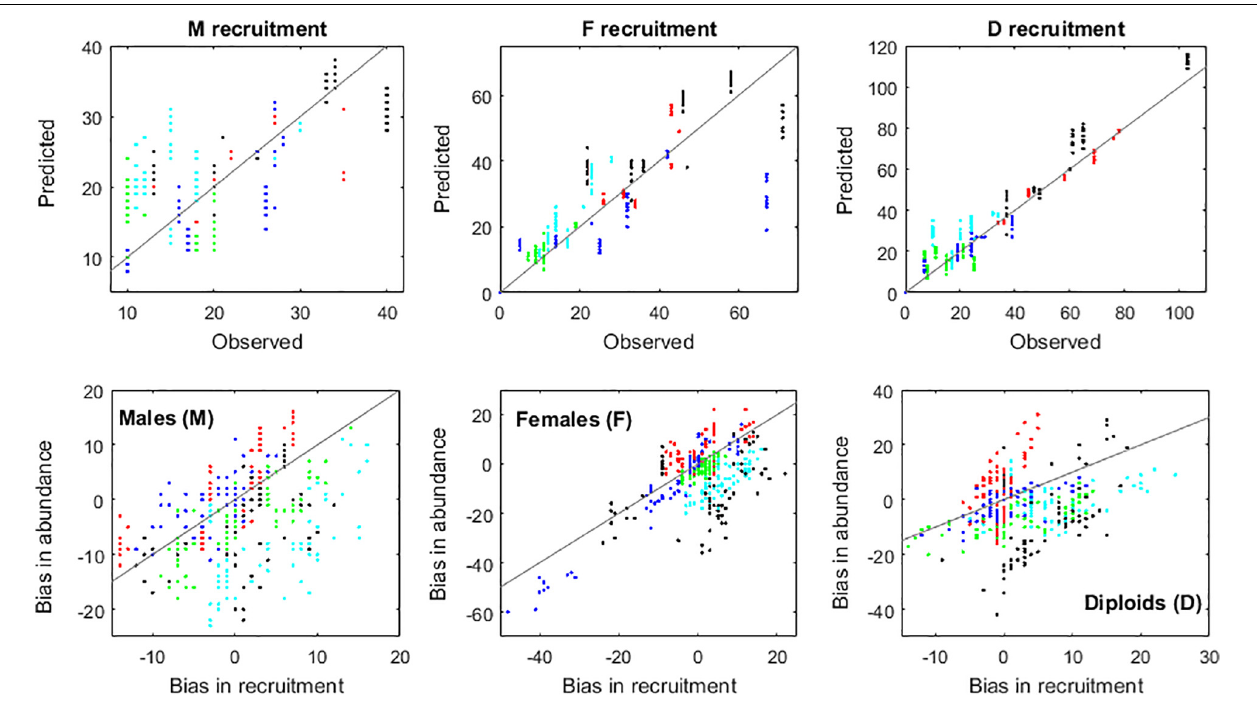
FIGURE 11 | Validation of the recruitment algorithm. Upper panels: comparison between observed and predicted recruitment. Bottom panels: Impact of the recruitment algorithm on the IBM performance. Markers represent plots Corral 1 (black), Corral 2 (red), Niebla 1 (green), Niebla 2 (light blue), and Niebla 3 (dark